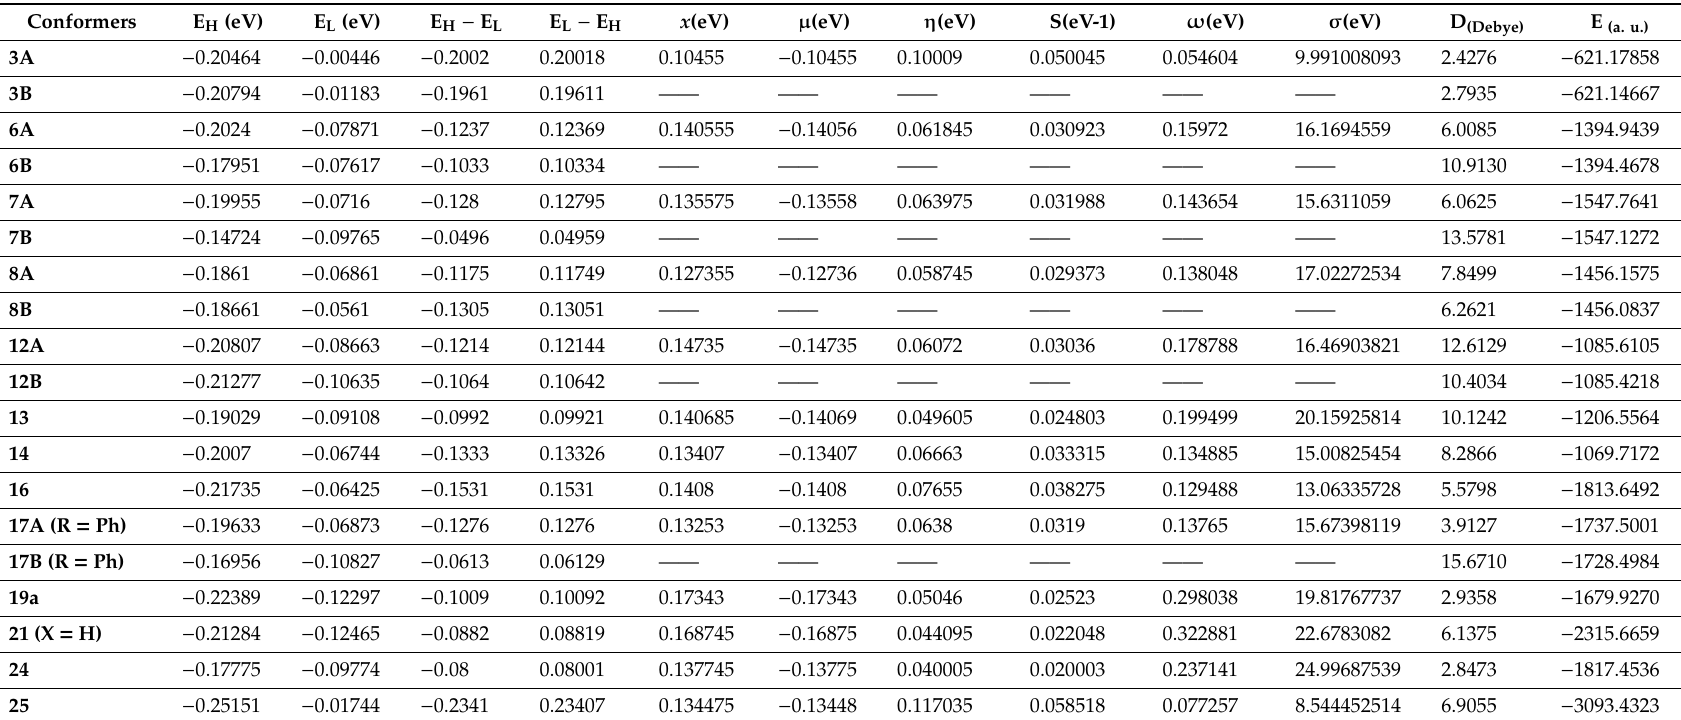
Table 1. Calculated physical parameters for all suggested